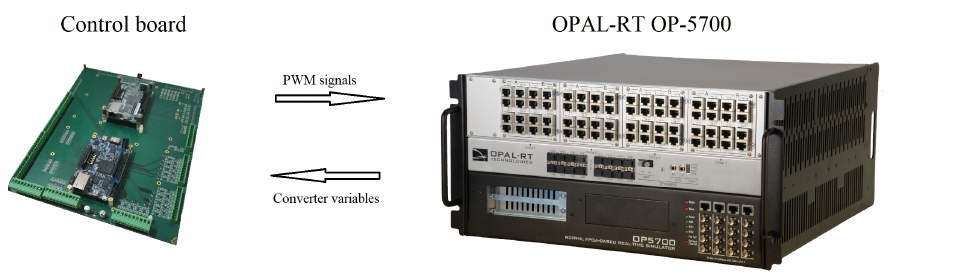
Figure 6. A picture of the control board where the control strategy is implemented, and the HIL OPAL-RT OP-5700, which is responsible for the real-time converter emulation.